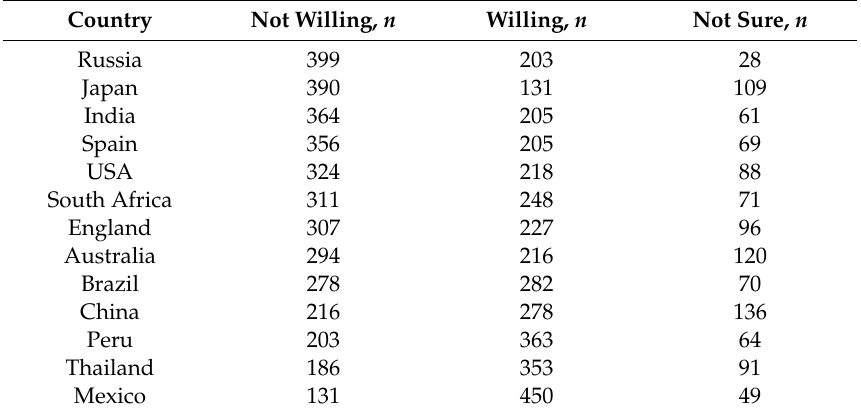
Table 2. The number ( n ) of consumers in each country who were not, were, and not sure about